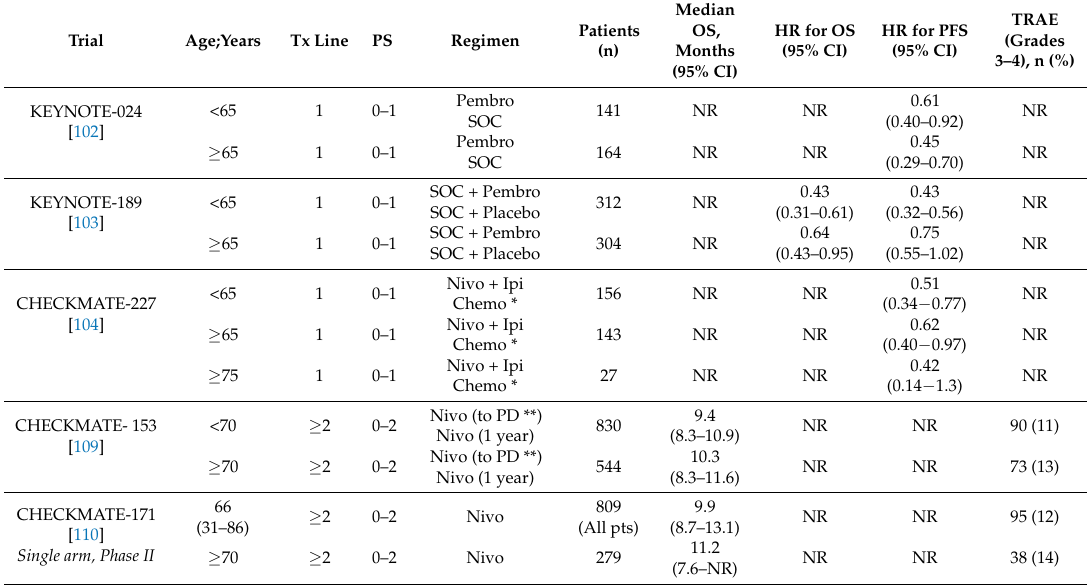
Table 5. Subgroup analyses of elderly patients in trials of immune-checkpoint inhibitors in NSCLC.